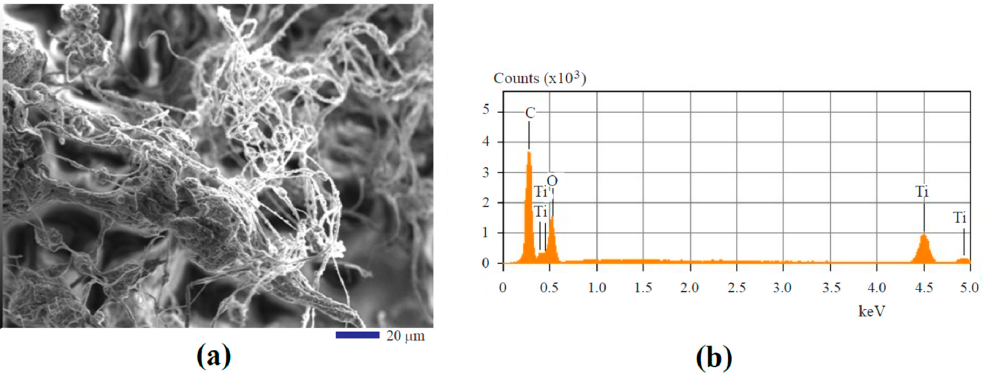
Figure 4. Energy dispersive spectroscopic analysis of the microfiber specimen: (a) a Scanning Electron Microscope (SEM) image showing the selected area for mapping; (b) spectrum from the area mapping.